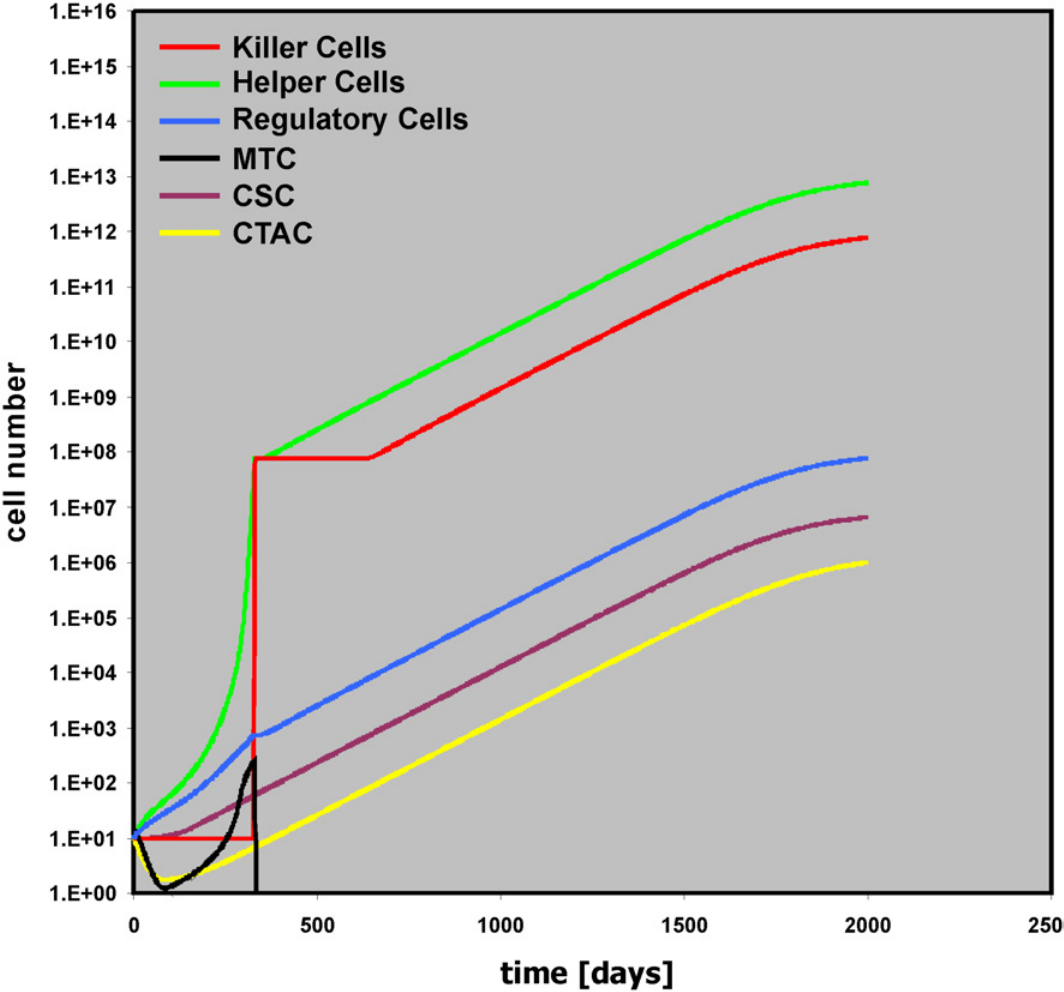
Fig 5. Insufficient tumor control despite increased cellular cytotoxicity against mature tumor cells. In this simulation the cytotoxicity of “ Killer Cells ” against mature tumor cells was increased (Kill of MTC = 0.1). Without killing of CSC, tumor control is